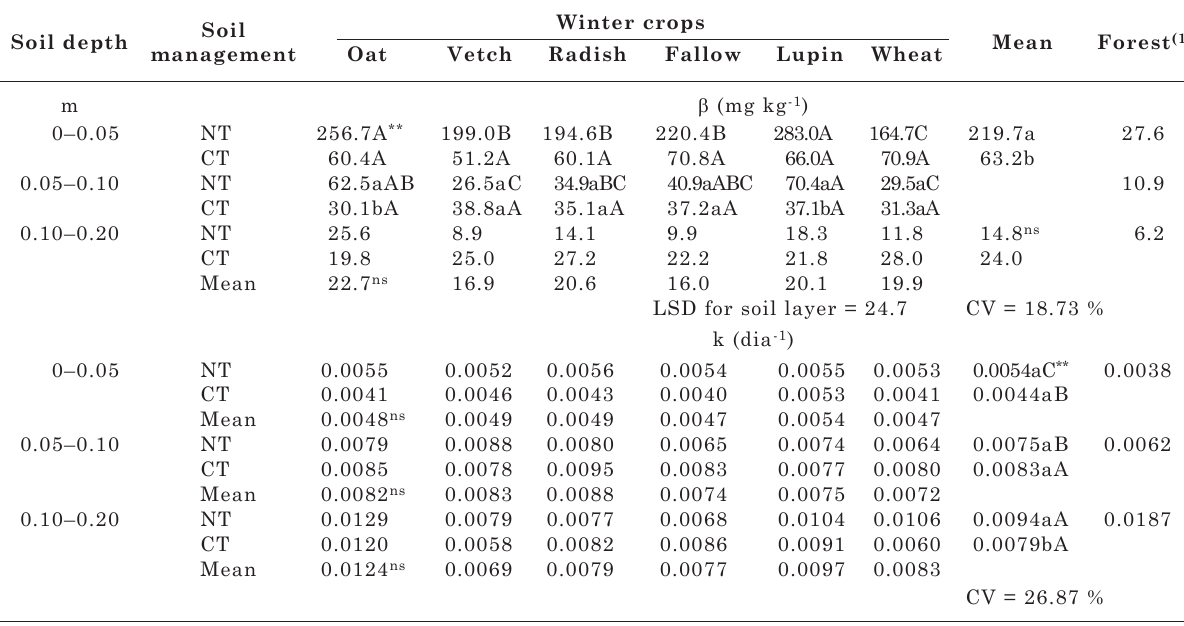
table 4. desorption maximum with anion exchange resin ( β ) and desorption rate constant (k) after 23 years of different soil management and winter crops of a rhodic hapludox